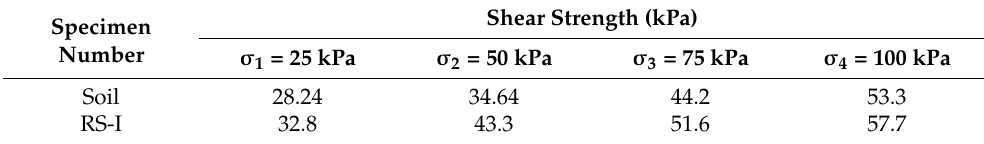
Table 5. Shear strength of specimens under different normal stress in shear resistance